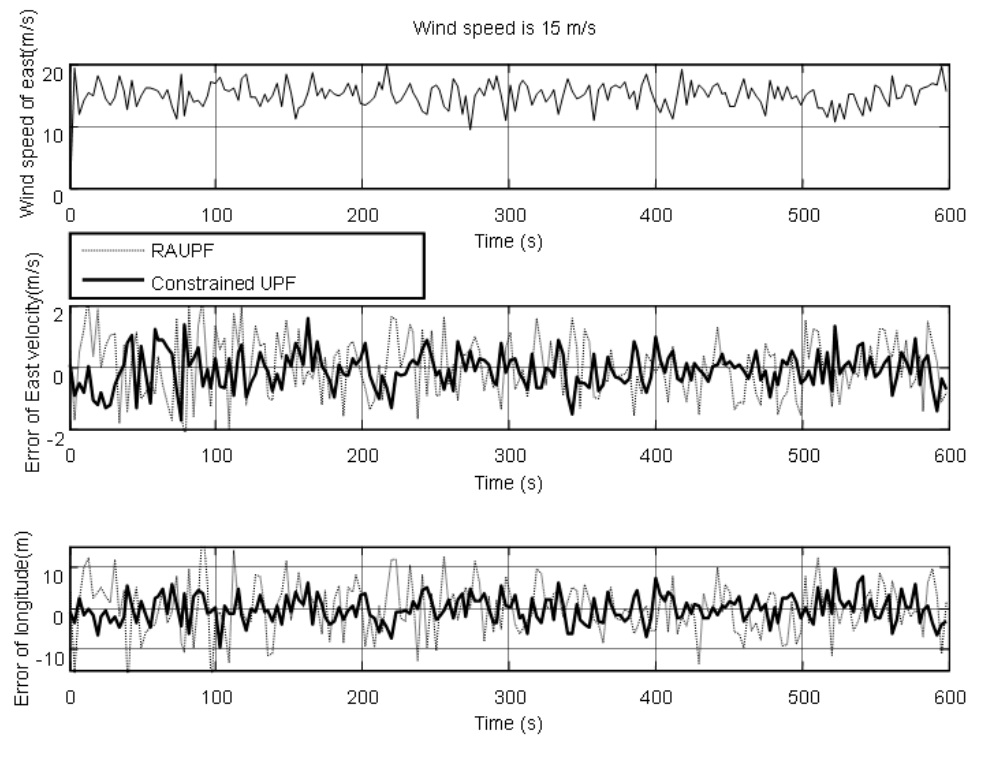
Figure 5. East velocity and longitude errors under the wind speed of 15 m/s.